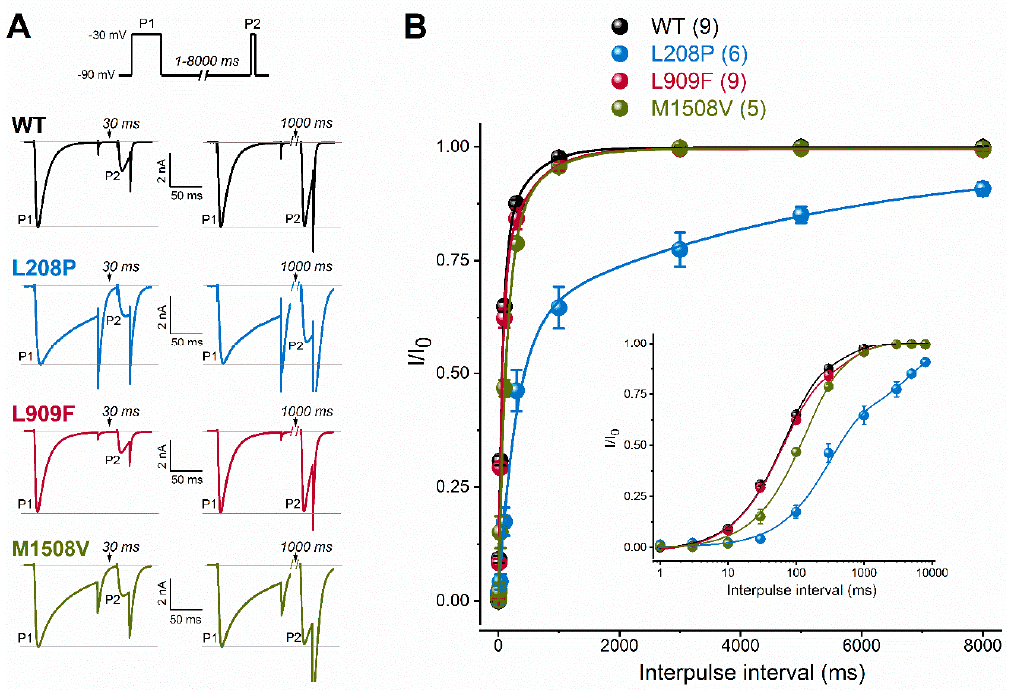
Figure 3. Recovery from fast inactivation of WT and mutant Ca v 3.1 channels. ( A ), Recovery was evaluated with a paired-pulse protocol of depolarizing the cells for 100 ms (P1) and varying the interpulse interval (between 1 and 8000 ms) before the P2 pulse. Representative P1- and P2-elicited traces separated by 30 and 1000 ms recovery interpulse intervals (left). Horizontal grey lines indicate zero-current and P1-elicited maximum-current levels. ( B ), Plots of normalized WT and mutant peak calcium currents as a function of interpulse duration. (inset: same dataset with a logarithmic time scale). Data are mean ± SEM; the number of experiments, n, is shown between parentheses. The recovery time course could be described by two kinetic components (Equation (3)). Relative to WT, parameters of recovery remained largely unchanged except for the mean fast and slow time constants of the L208P variant ( p < 0.0001 and p < 0.001, respectively, in one-way ANOVA followed by Dunnett’s post-hoc test; see Table 1). Table 1. Biophysical parameters of Ca v 3.1 channel variants expressed in HEK-293T cells.